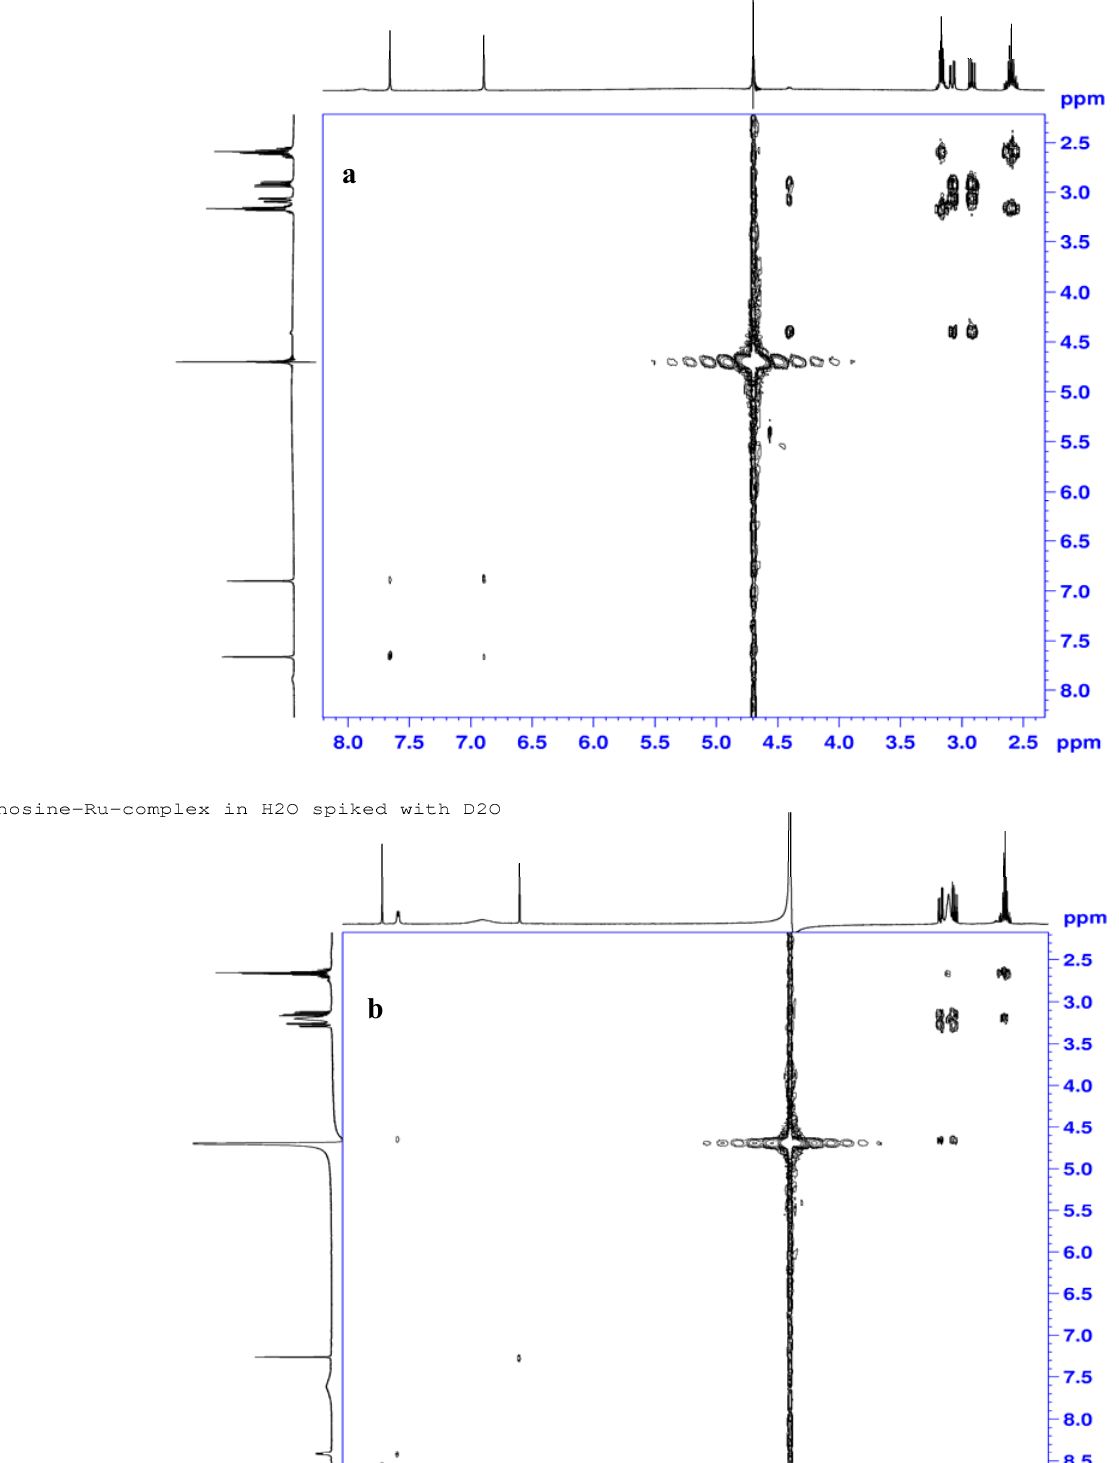
Figure 6. 1 H-NMR COSY Spectra for L -carnosine ( a ) and Ru-carnosine complex ( b